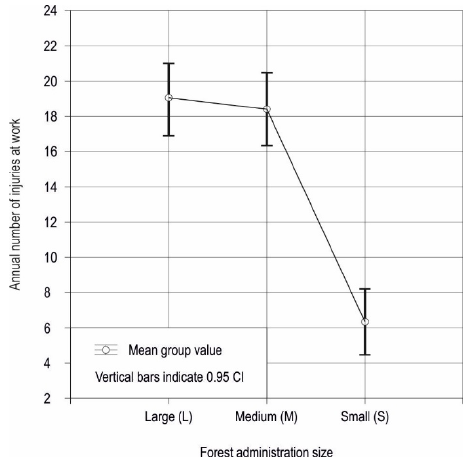
Figure 5. Mean value of annual number of injuries between groups.